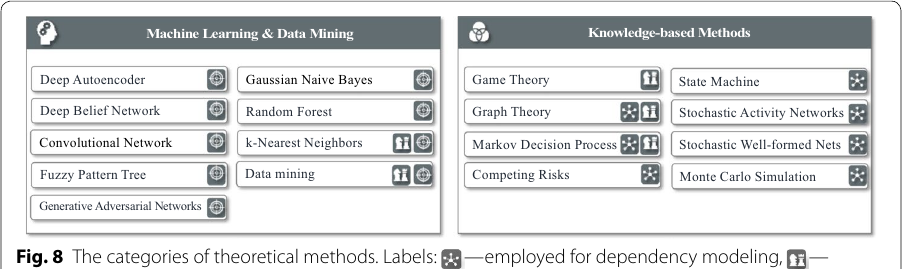
Fig. 8 The categories of theoretical methods. Labels: —employed for dependency modeling, — employed for risk assessment, —employed for attack